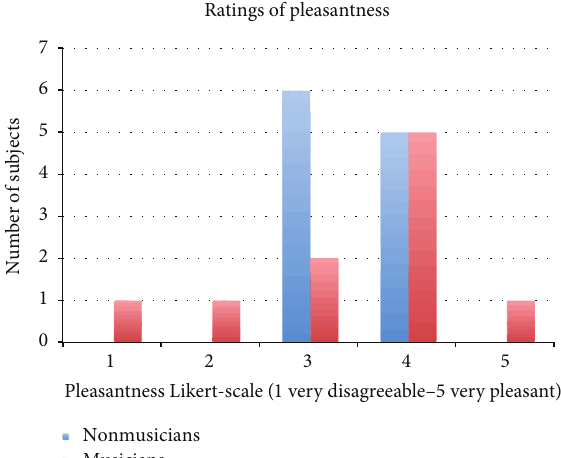
Figure 13: Chart of ratings of application’s pleasantness (average of ratings 3.4 for nonmusicians and 2.9 for musicians).